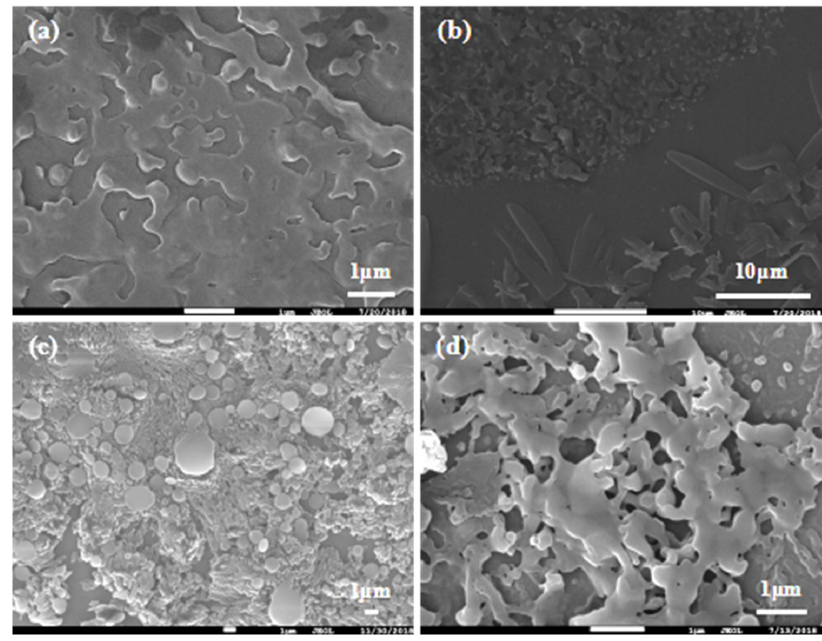
Figure 9. Recrystallization at different β : ( a ) β = 47; ( b ) β = 105; ( c ) β = 188; and ( d ) β = 293.